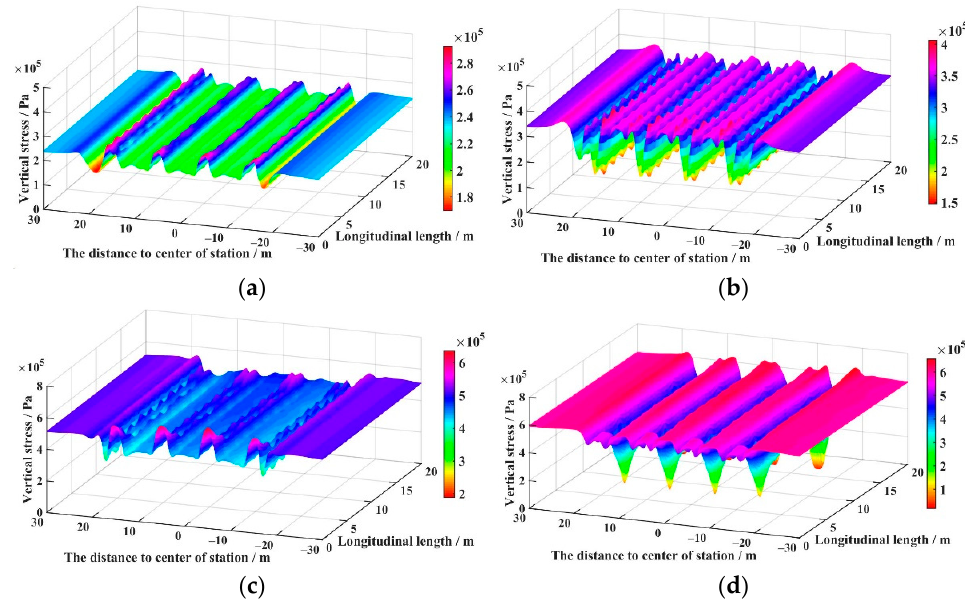
Figure 7. Stress fields of scheme 3 (S—1-3-2-4-5-7-6-8): ( a ) P1 (z = 4.5 m), ( b ) P2 (z = 0 m), ( c ) P3 (z = − 8.3 m), and ( d ) P4 (z = − 12.8 m). ( c ) P3 (z = − 8.3 m), and ( d ) P4 (z = − 12.8